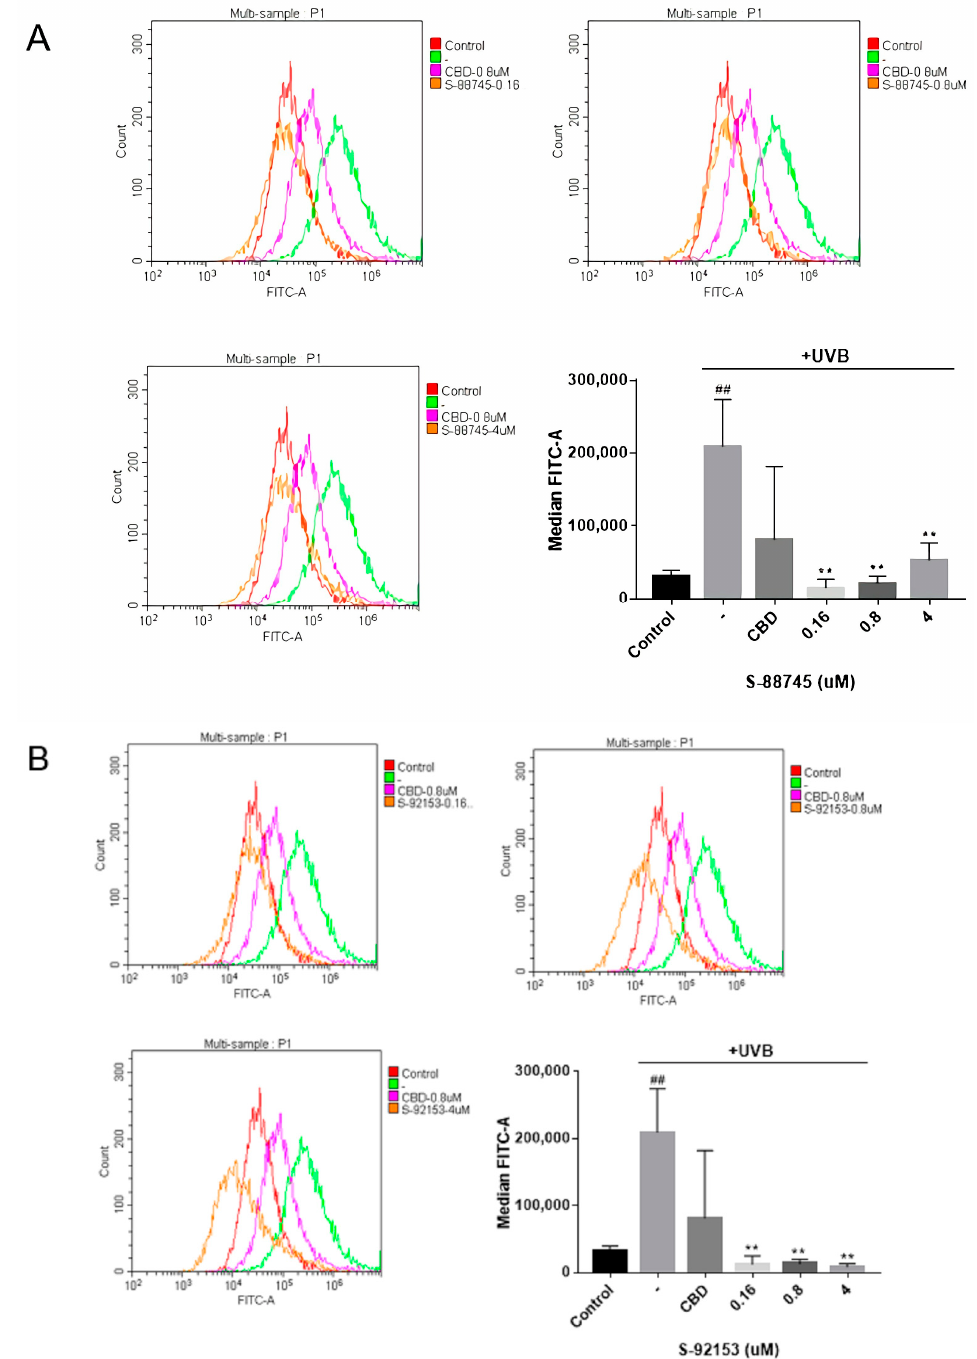
Figure 10. Inhibition of CBD, S-88745 and S-92153 on UV-induced ROS in HFF-1. Each bar illustrates the average ± standard deviation (SD) counted from three experiments. ( A ) ROS content of S-88745 and CBD (0.8 µ M). ( B ) ROS content of S-92153 and CBD (0.8 µ M). The control group was not stimulated by UV. The UV-treated group (-) produced a lot of reactive oxygen species after UV stimulation. The experiments were repeated three times. Each bar illustrates the average ± standard deviation (SD) counted from three experiments. p < 0.05 was considered statistically significant. ** p < 0.01 compared to the UV − treated group; ## p < 0.01 compared to the control